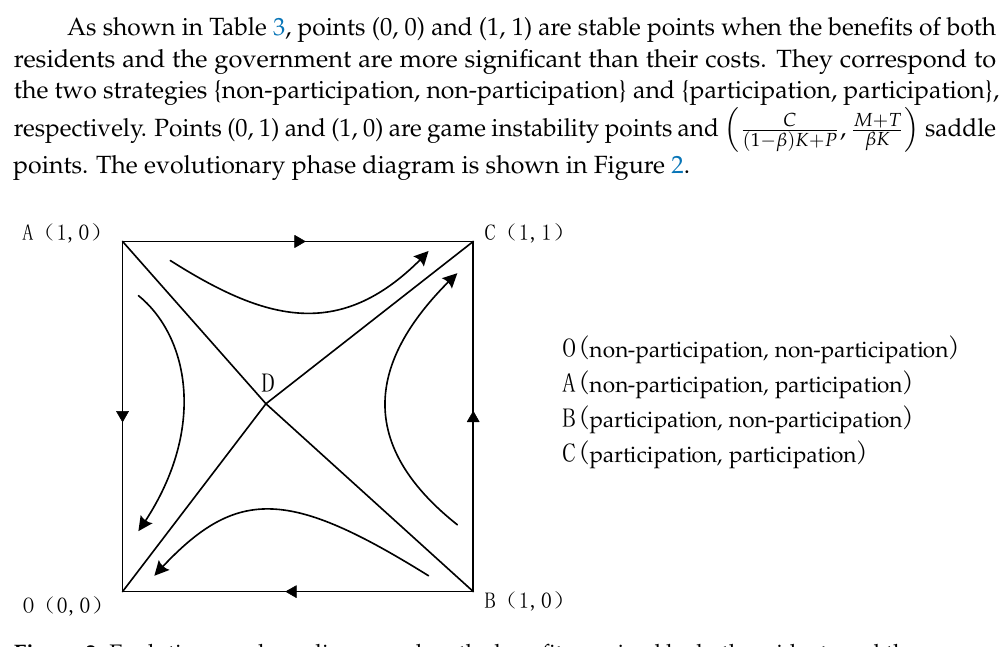
Figure 2. Evolutionary phase diagram when the benefits received by both residents and the govern- ment are more significant than the costs paid by them.